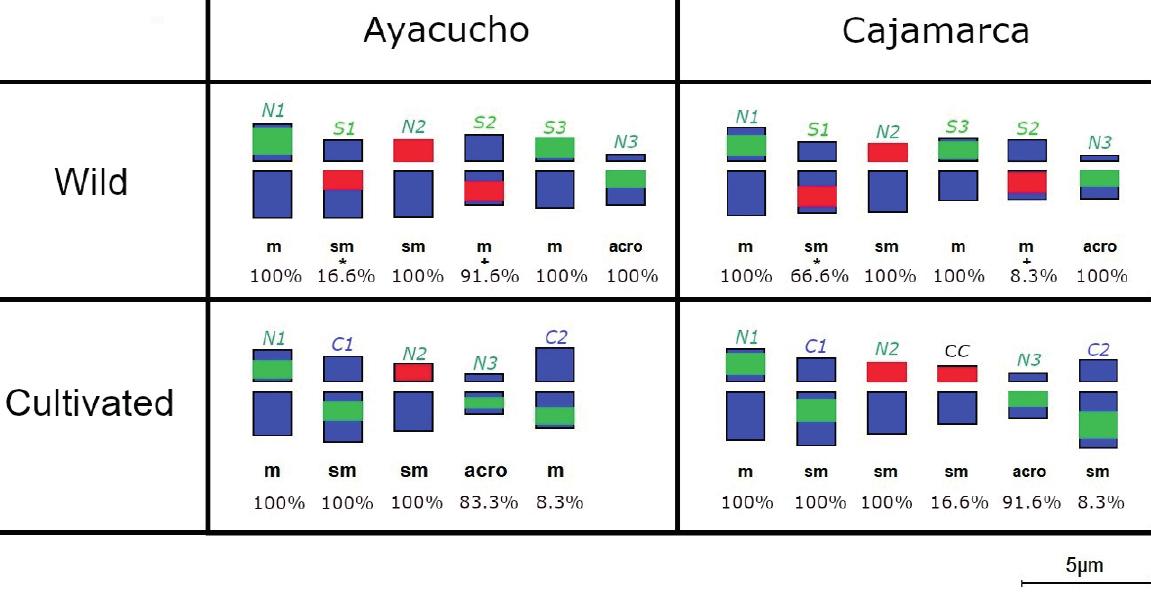
Figure 6 The average ideogram of the types of chromosomes that included rDNA. The proportion observed in the total of the meta- phases analyzed by each population is indicated beneath each chromosome. Equal symbols above the percentages indicate a significant difference between the observed frequencies of both populations (Fisher’s Exact Test, p<0.05). m=metacentric, sm=submetacentric, and